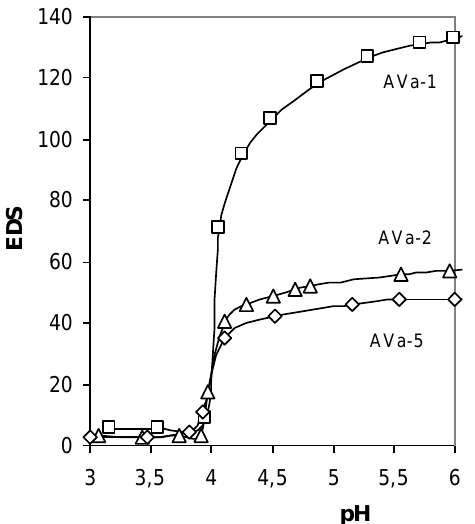
Figure 1. Equilibrium degree of swelling (EDS) in relation to pH for the hydrogels AVa-1, AVa-2, and AVa-5 at 25 °C and 0.15 M